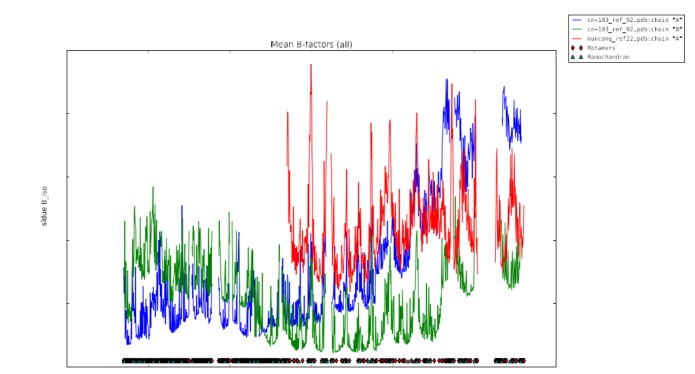
DOI:
http://dx.doi.org/10.7554/eLife.22567.032